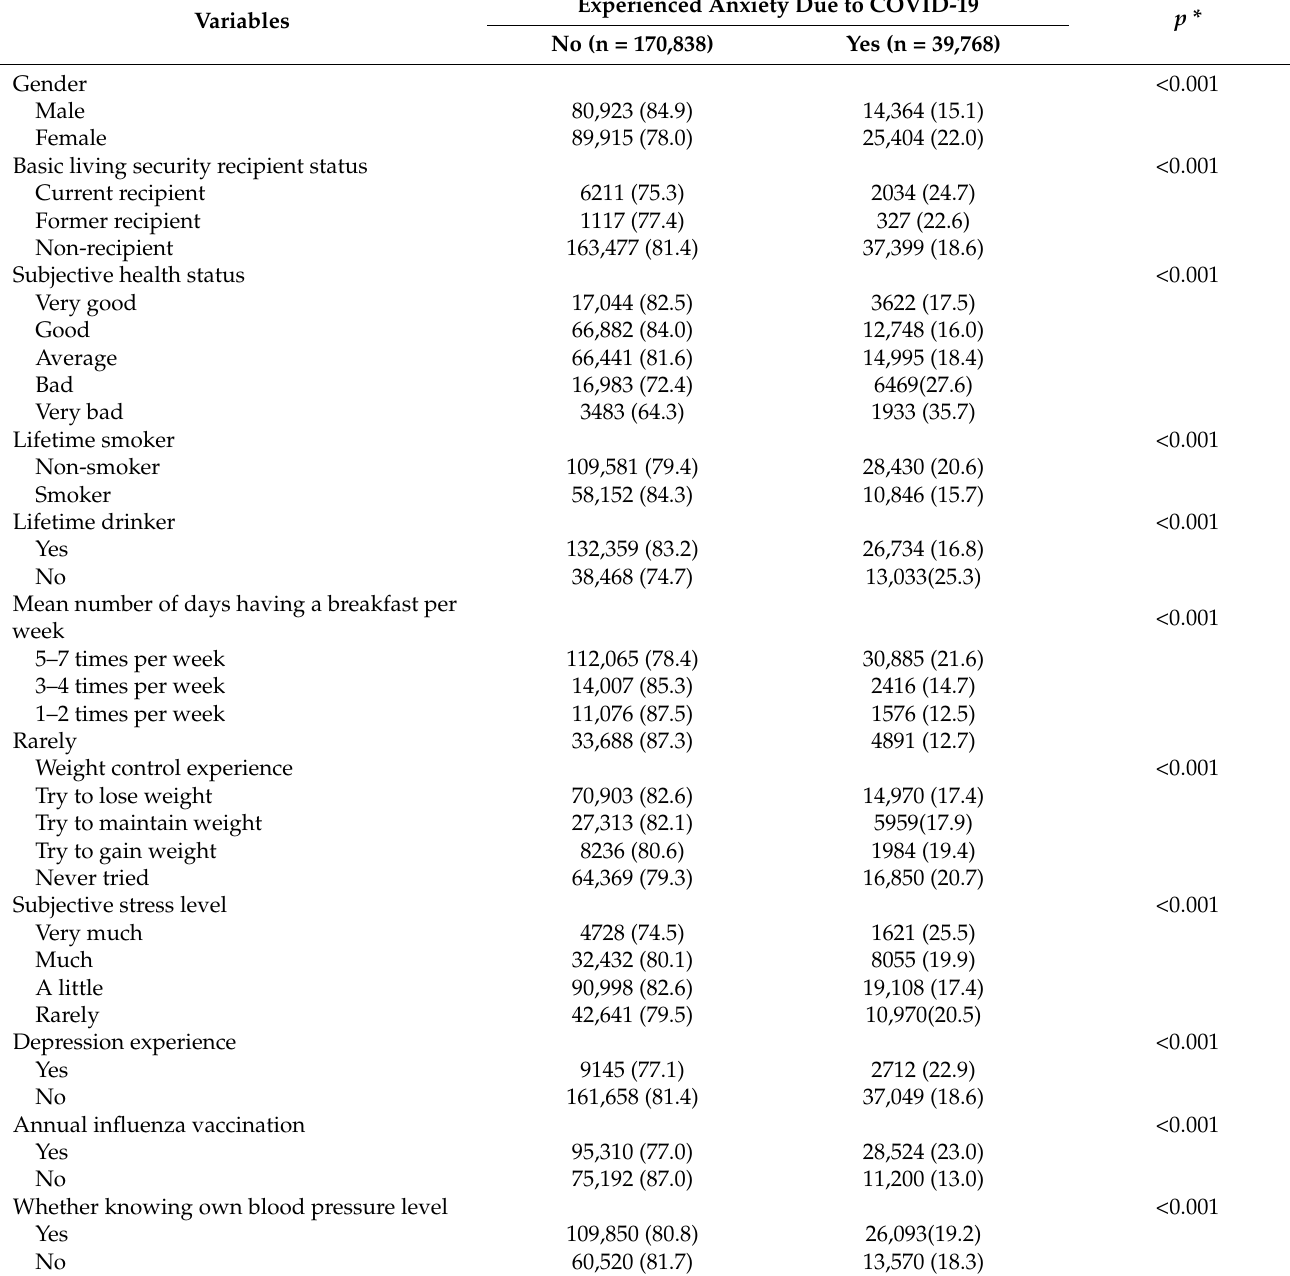
Table 2. The general characteristics of adults who experienced anxiety due to COVID-19: univariate analysis.